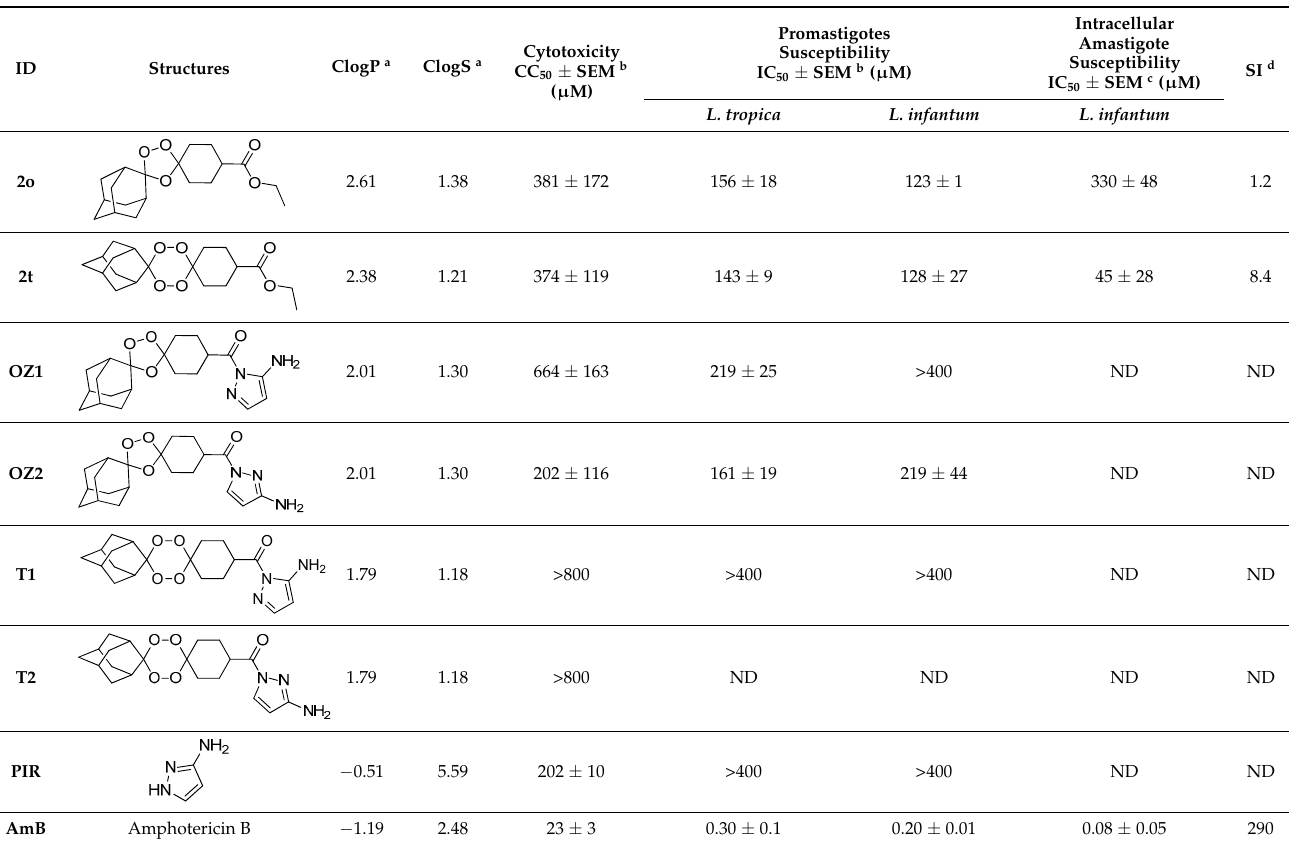
Table 4. Estimated ClogP and ClogS values, cytotoxic concentrations (CC 50 ) in THP-1 cell line, inhibitory concentrations (IC 50 ) in promastigotes of L. infantum and L. tropica and intracellular amastigotes of L. infantum , and selectivity index (SI) of synthetic endoperoxide–pyrazole hybrids, and amphotericin B (control).